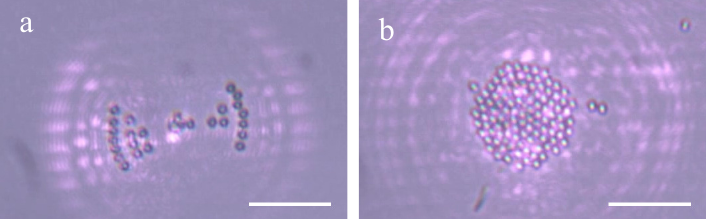
Figure 5. Images of the 1 µ m particles assembly formed by the diffraction patterns of the cylindrical vector beams. ( a ) azimuthally polarized beam. The particles form a two-fan-shaped structure at the interface; ( b ) radially polarized beam. Most of the particles are driven into the center and form a compact structure at the interface. The amount of 1 µ m particles in the solution is 2 × 10 8 cm − 3 . Laser power is 450 mW; scale bar, 10 µ